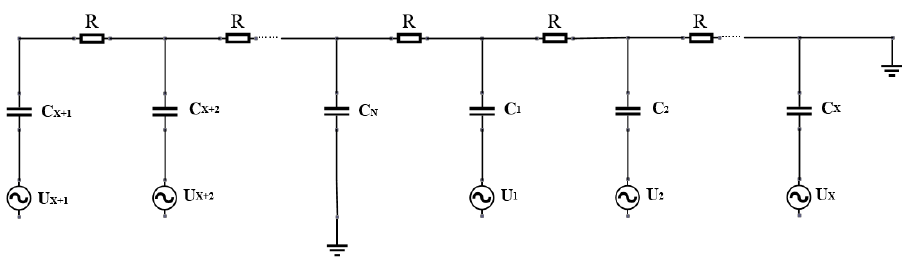
Figure 2. Network model of stator and rotor with common grounding point.